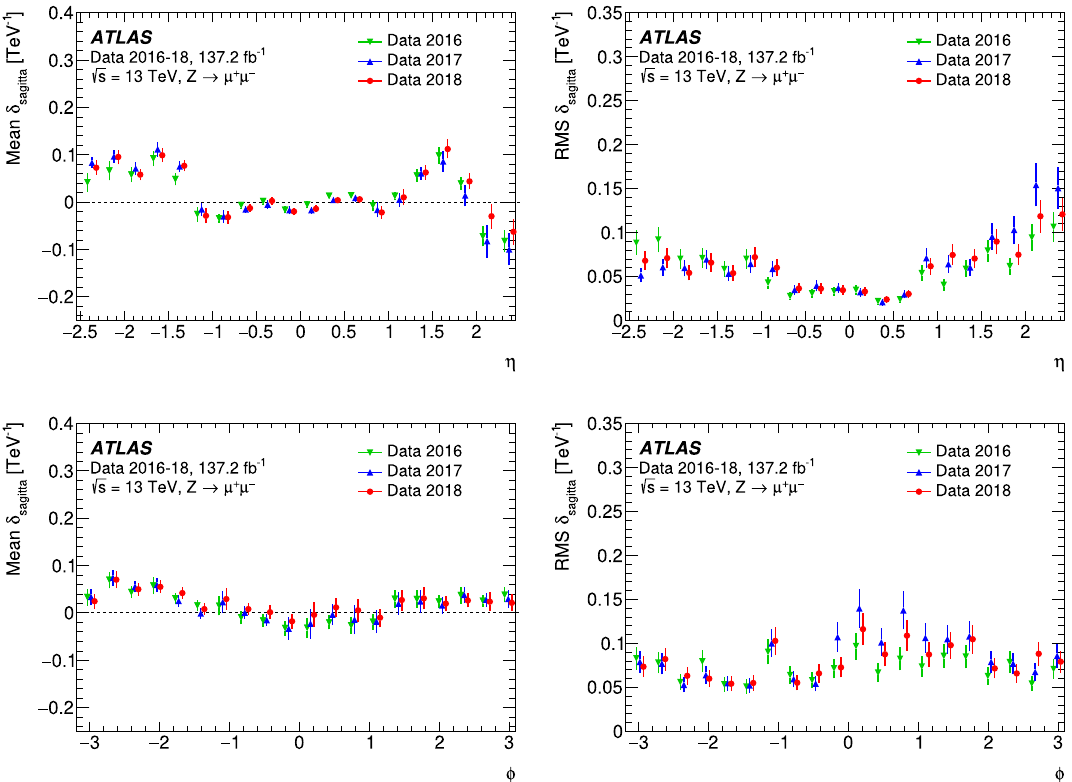
Fig. 19 Measured sagitta biases versus η (top) and φ (bottom) using the Z → μ + μ − method. The average (left) and the RMS (right) of the sagitta bias is shown. The markers of the data points of the different years are slightly shifted in η and φ for better visibility. The error bars represent the statistical